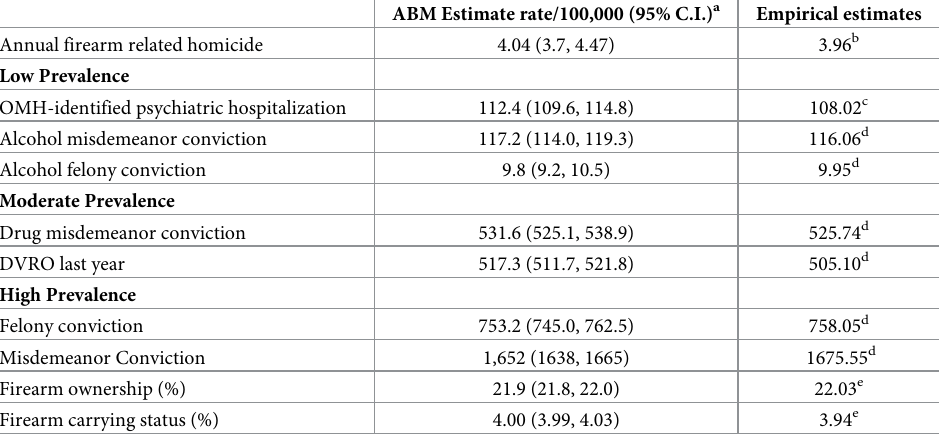
Table 1. Estimates of firearm related homicide, low, moderate, and high prevelance risk groups, and firearm car- rying and ownership from the ABM and empirical data sources in NYC when available, and from the National Comorbidity Survey